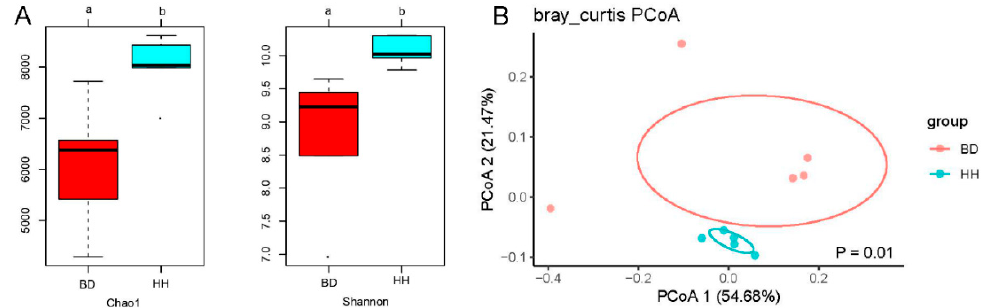
Figure 2. Alpha and beta diversities of the rumen microbial community. ( A ) Bacterial community richness (Chao1) and diversity index (Shannon) of rumen samples of the brisket disease group (BD) and healthy heifer group (HH); significant differences ( P < 0.05) were shown via using a and b; ( B ) Principal coordinate analysis (PCoA) of bacterial community composition of the ruminal microbiota in BD and HH. PCoA plots were constructed using the weighted UniFrac distance matrix.